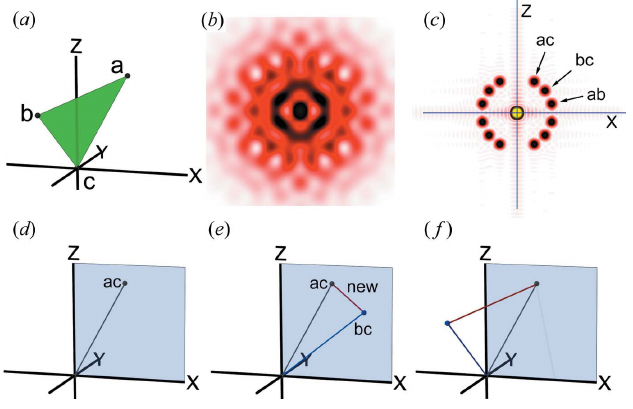
Figure 1 Reconstruction procedure of a 3D structure from its CAP. ( a ) The structure of an object, consisting of only three points (the green plane is for assisting purpose only), freely rotatable around the z axis. ( b ) The ‘fiber’ diffraction pattern from the object. ( c ) The CAP of the object, calculated from ( b ). ( d )–( f ) The reconstruction procedure. ( d ) One of the vectors (here, vector ac ) is placed as the starting vector on the x – z plane (pale blue). ( e ) A second vector ( bc ) is tentatively placed on the x – z plane and connected to the first vector, and this creates a new incorrect vector (red). ( f ) The second vector is rotated around the z axis, and now the new vector coincides with the unused vector ab and the reconstruction is